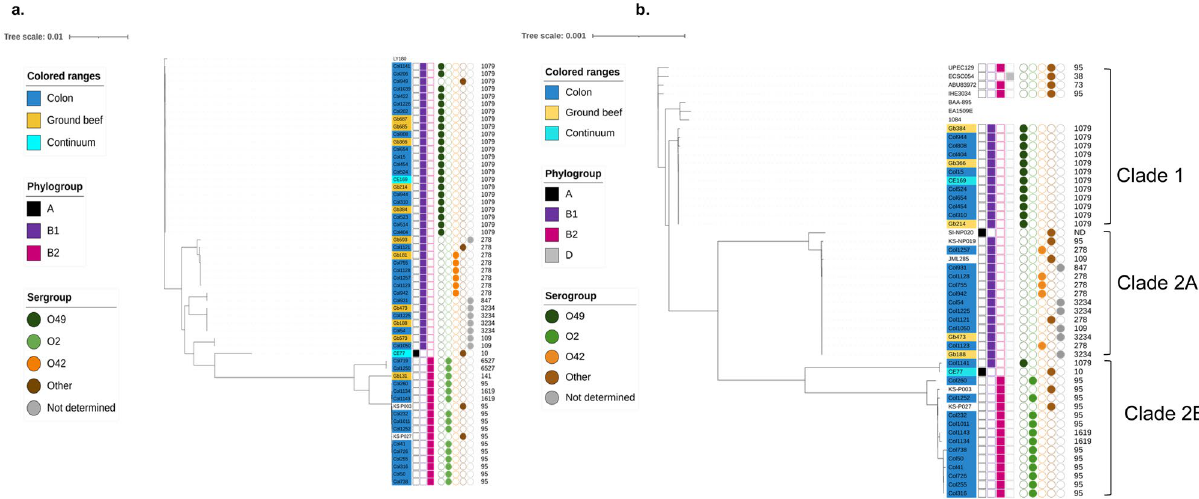
Figure 4. Maximum likelihood phylogenetic tree of ( a ) 54 core genomes of clb + E. coli isolated from beef production and processing continuum, and ( b ) 39 pks island sequences extracted from the contigs carrying full length pks island ( clbA - clbS ). Phylogenetic trees were constructed using IQ-tree and visualized with iTOL v6. Numbers on the outermost column represent multilocus sequence types (MLST).